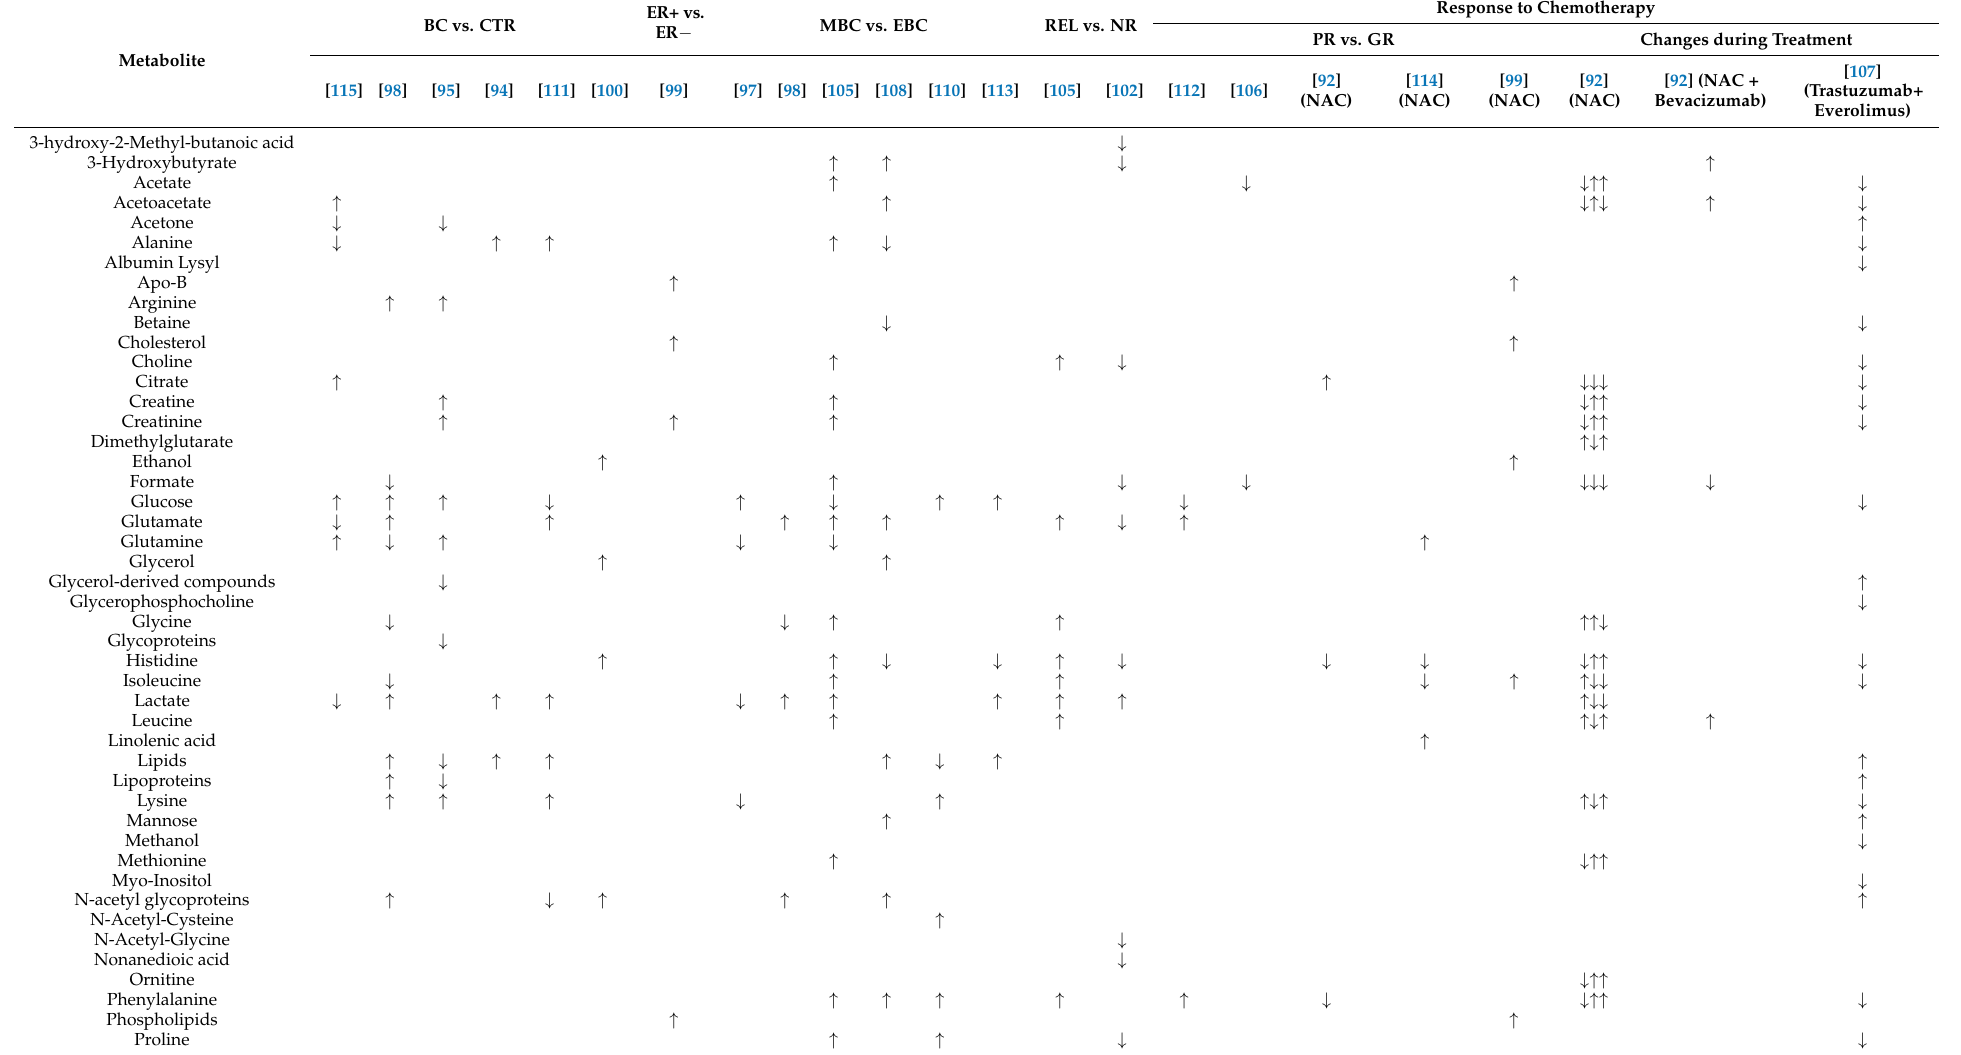
Table 4. List of altered metabolite levels identified in plasma/serum samples of BC patients to study several aspects of this pathology.